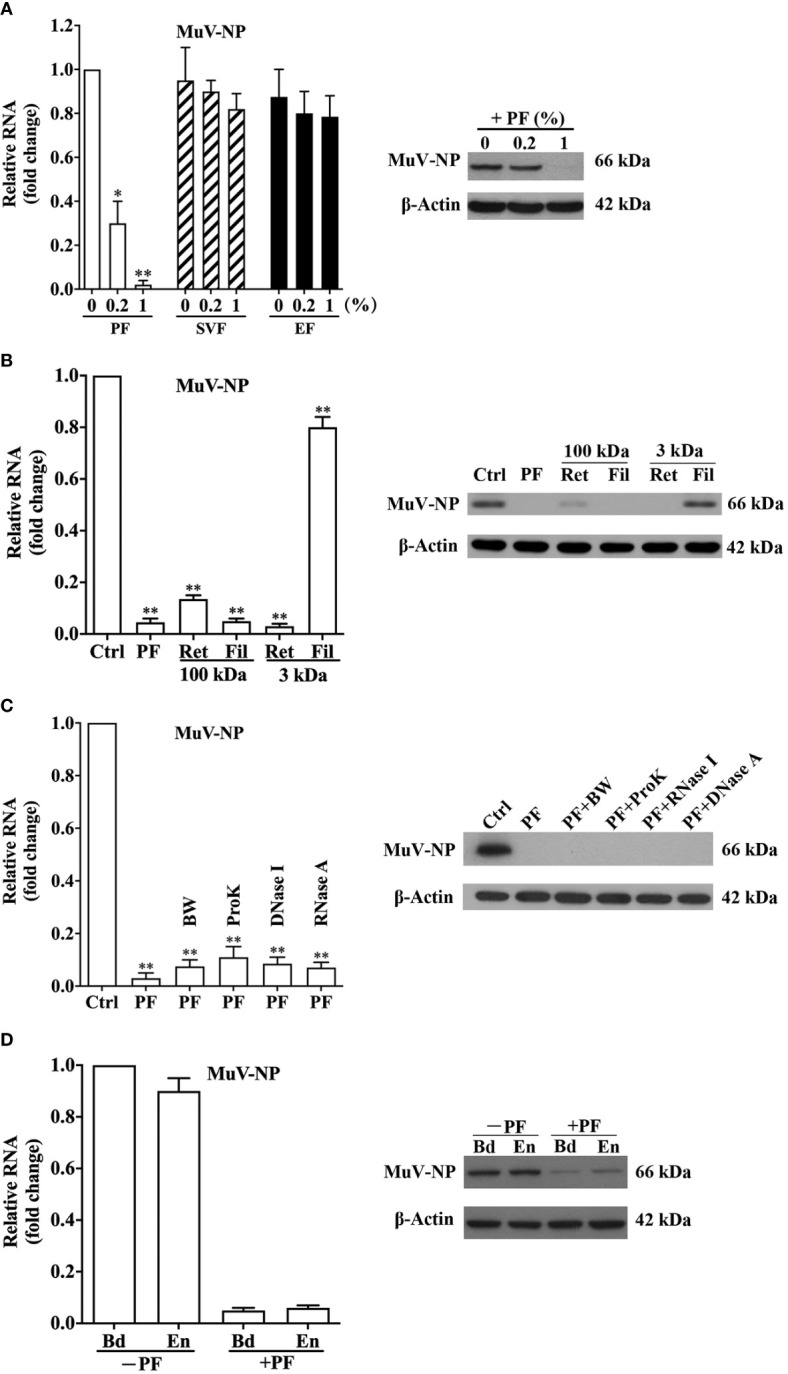
Antiviral effect of male genital tract fluids. (A) Antiviral effect of prostatic fluids (PF), seminal vesicle fluids (SVF), and epididymal fluids (EF). MuV was incubated with the indicated doses of PF, SVF, or EF at 37°C for 2 h, and HeLa cells were infected with 1.0 MOI of MuV. At 48 h after infection, MuV-NP RNA levels (left panel) were determined using real-time qRT-PCR. The inhibition of PF on MuV-NP protein level (right panel) was analyzed by a Western blot. (B) Antiviral effect of PF fractions. PF were filtered through a 3-kDa filter, and MuV was incubated with either 1% filtrate (Fil) or 1% retentate (Ret) at 37°C for 2 h. MuV without treatment served as the control (Ctrl). HeLa cells were infected with 1.0 MOI of MuV. MuV-NP RNA (left panel) and protein (right panel) levels were determined 48 h after infection. (C) Properties of the antiviral factor in PF. PF were treated in boiling water (BW) for 5 min, or incubated with Proteinase K (ProK), DNase I, or RNase A at 37°C for 5 h, followed by heating inactivation in BW for 5 min. MuV was incubated with 1% PF for 2 h, and HeLa cells were infected with 1.0 MOI of MuV. MuV-NP RNA and protein levels were determined 48 h after infection. (D) MuV binding (Bd) and entry (En). MuV was pre-incubated with 1% PF (+PF) or without PF (-PF) at 37°C for 2 h. HeLa cells were inoculated for 1 h with 50 MOI MuV on ice for binding or at 37°C for entry. MuV-NP RNA (left panel) and protein (right panel) levels were determined. Images represent at least three independent experiments. Data are presented as means ± SEM of three experiments. *P < 0.05, **P < 0.01.